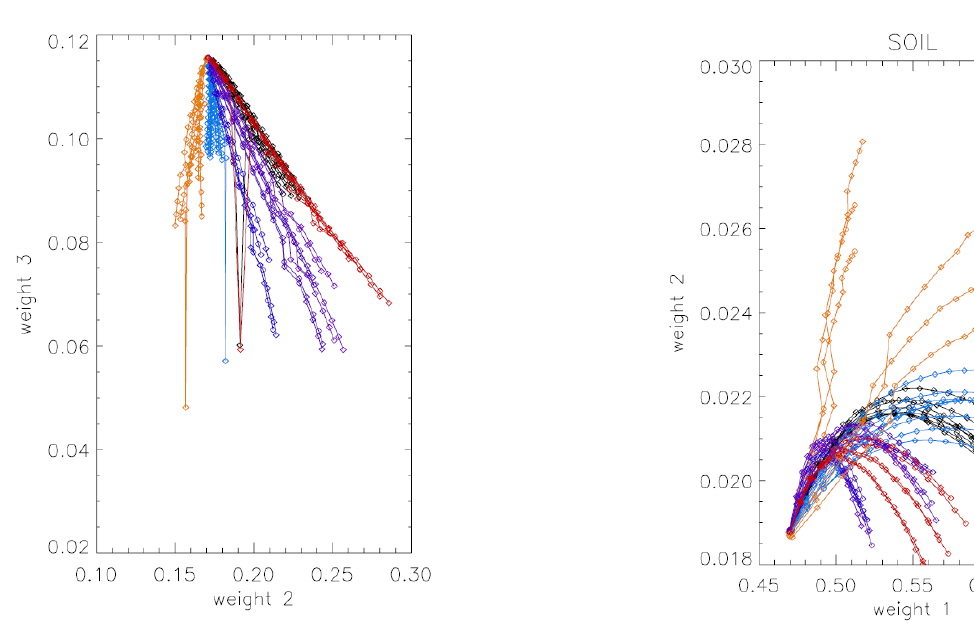
Fig. 5b Distribution of retrieval in the space of second and third weights for 40 aerosol mixtures for all measurement scenarios. Retrieval scenarios with the same parameters but with varying optical thickness are connected with solid lines. There are five domains marked with different colours: the domain of diesel and biomass burning (red), the domain of polluted aerosol (dark blue and violet). Other domains: maritime (blue), continental (black) and desert dust (sienna). In this case black and red lines are not separated.